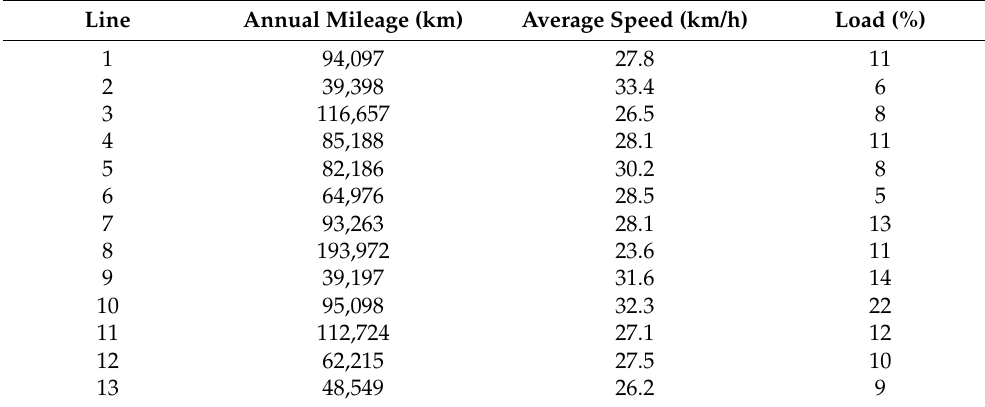
Table 2. Input real-world data of bus fleet for the emission calculation for the researched bus lines. Line Annual Mileage (km) Average Speed